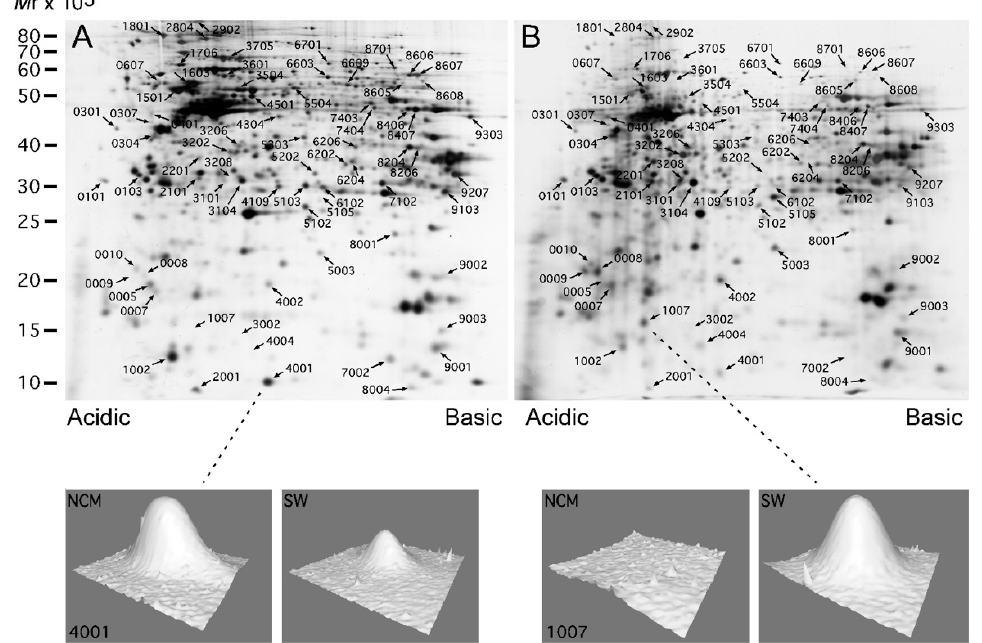
Figure 2. Proteomic analysis of NCM460 and SW480 using a top-down proteomic strategy. A representative gel from each group ( A ) NCM460 and ( B ) SW480, molecular mass is given in kDa. NCM460 and SW480 cells were grown in separate rounds and harvested prior to total protein concentration determination and equal amounts of protein were loaded on the gels. Each group consisted of 6 samples. Comparative analyses of the spots were done with the PDQuest software. All differentially identified spots with 2-fold or more increased/decreased expression and with significance level ( p < 0.05) with Mann-Whitney U-test are shown on the representative gels in the figure. Table 2. Identification of differentially expressed proteins in SW480 versus NCM460 cells.